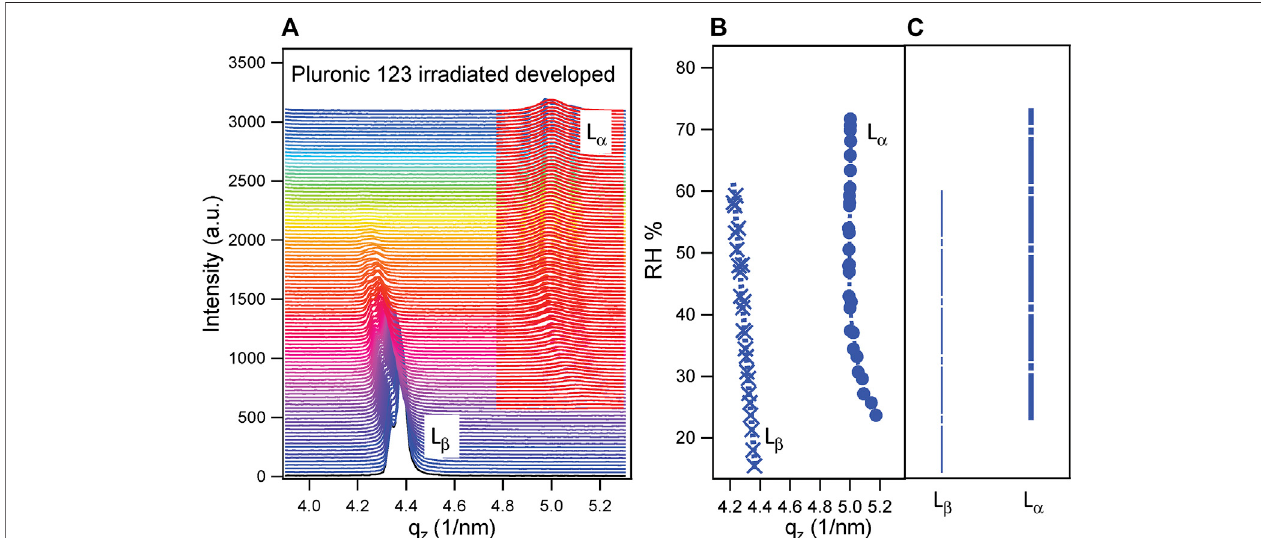
FIGURE 4 | (A) Out-of-plane pattern (I – q z ) at increasing RH for POPC deposited on a thin mesoporous silica fi lm prepared with surfactant P123, irradiated and developed. The two phases L β and L α are shown, evidencing the structural transition of POPC upon increasing relative humidity. The red curves, superimposed to the measured ones in correspondence with the L α phase, represent the Lorentzian fi tting of the peaks of the lamellar phase. (B) q z resulting from the Lorentzian fi tting of the L β phase (left) and L α phase (right) as a function of RH (%). (C) Scheme of the RH (%) range of existence of the L β phase (left) and L α phase